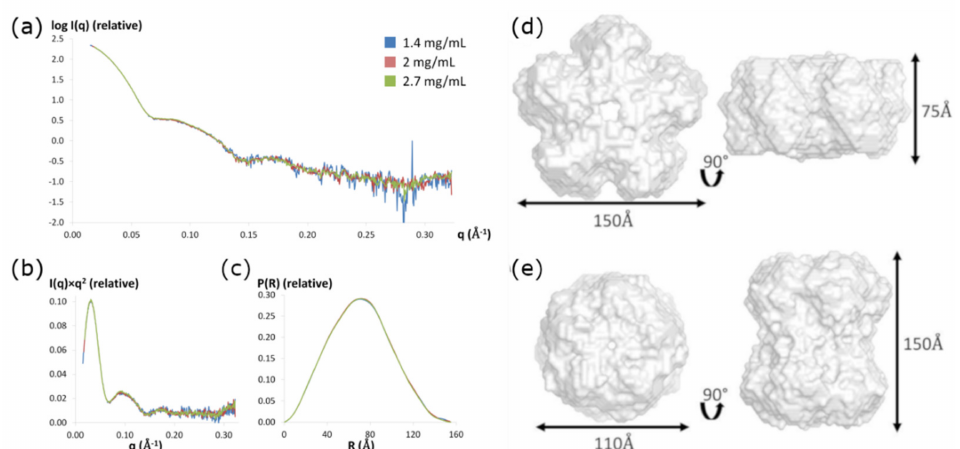
Figure 4. ( a ) Experimental scattering patterns for three concentrations of ascc ϕ 28 gp11 scaled to concentration. ( b ) Kratky plots and ( c ) pair-distance distance distribution functions P(R) of ascc ϕ 28 gp11 for three concentrations. The two classes of molecular envelopes, generated using GASBOR, are consistent with the X-ray scattering curve of gp11. D5 symmetry was imposed. Either a flatter oblate cylinder ( d ) or a more elongated prolate cylinder ( e ) are consistent with the SAXS measurements.